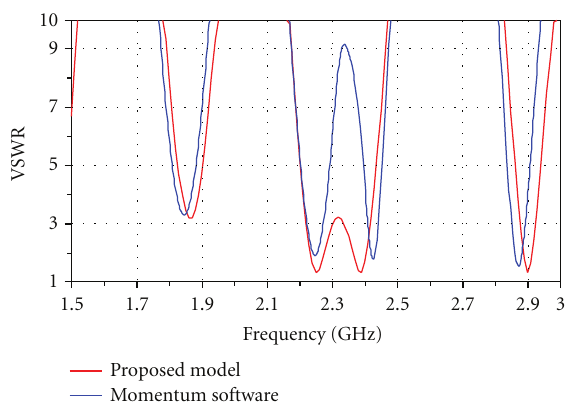
Figure 8: Bow-tie antennas array